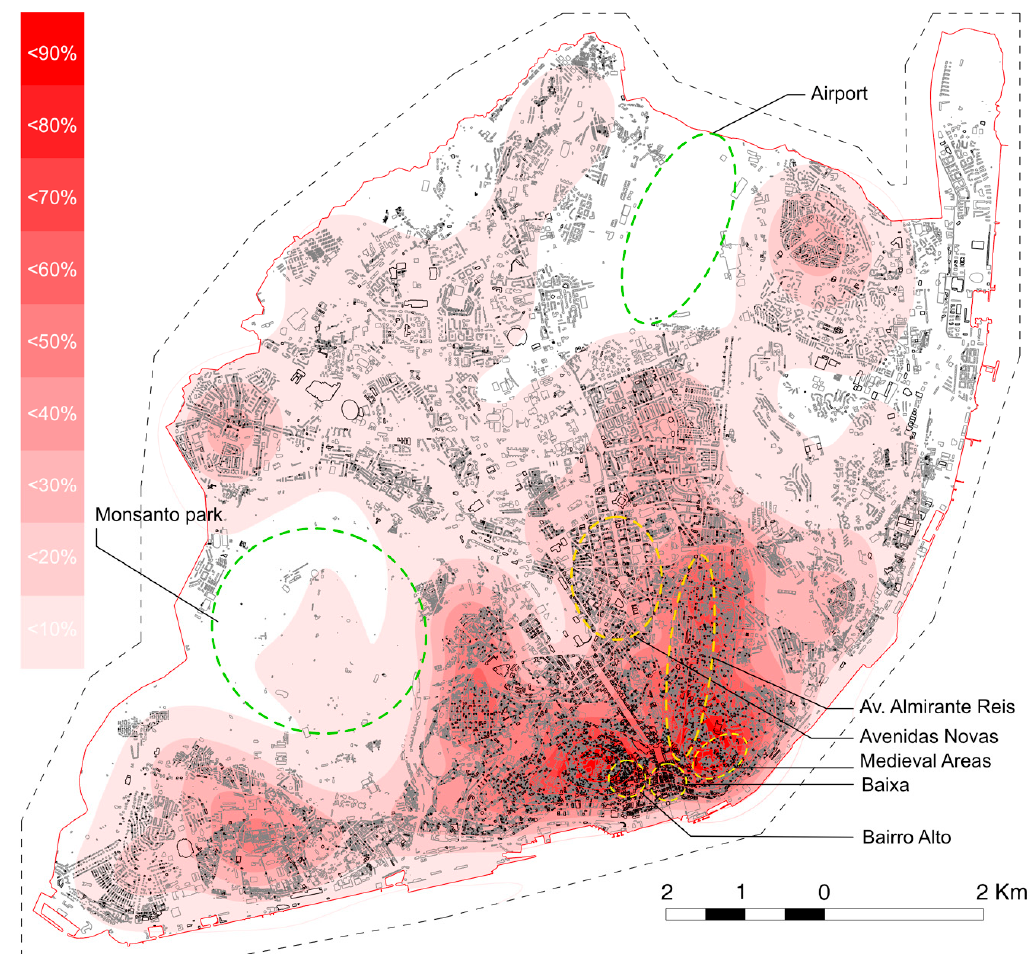
Figure 4. Adaptive KDE of all the buildings in the city of Lisbon, h = 1600 m. Output of Grasshopper to Rhino. Source: Authors.